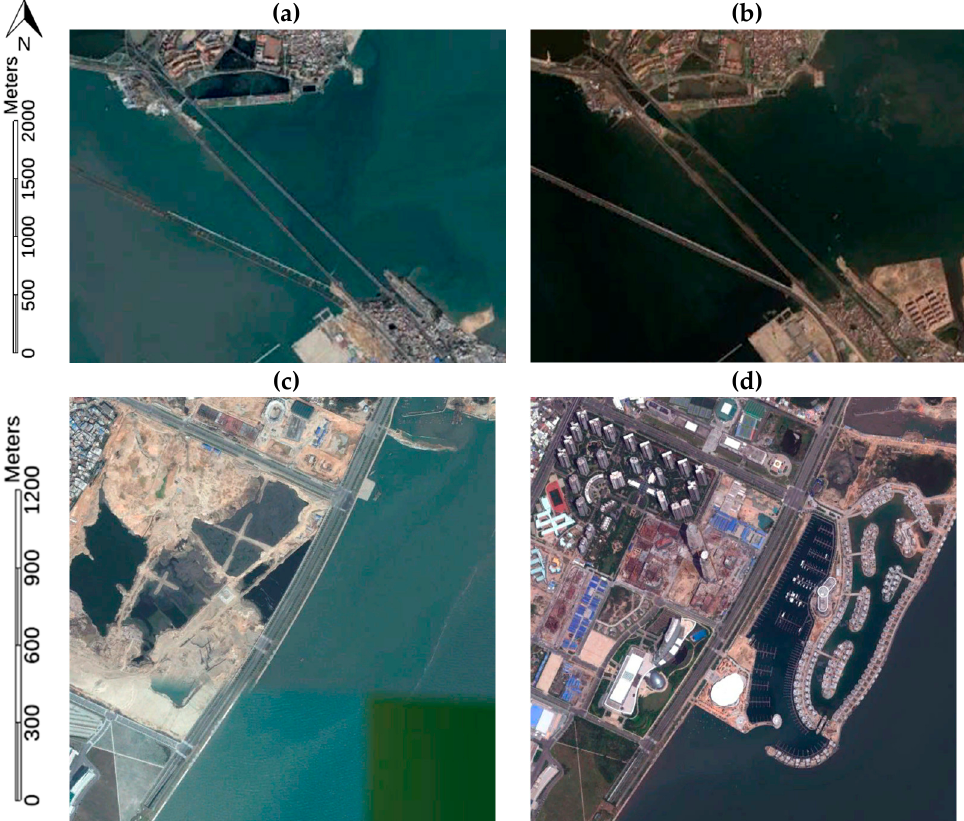
Figure 5. Optical image showing an example of new constructions of Xiamen testing area. The size of (a) and (b) image are 3.7 × 2.8 km and size of (c) and (d) image are 1.7 × 1.7 km. (a) Time 1 image